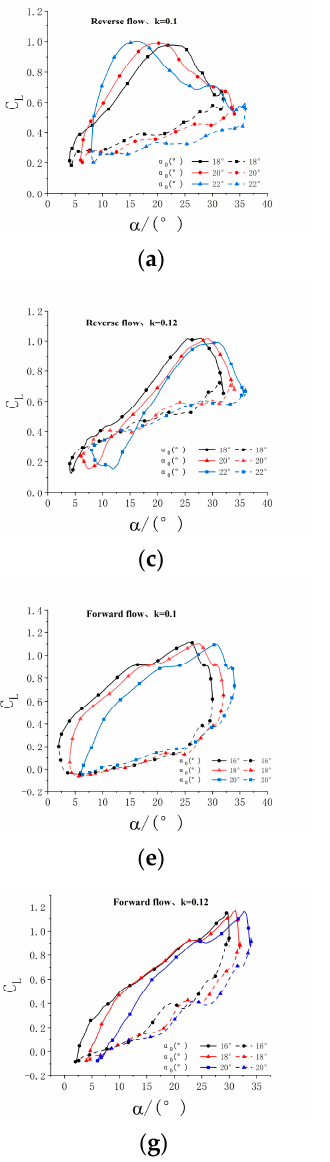
12 of 22 Figure 13. Pressure coefficient of suction and pressure sides of airfoil under reverse-blowing. 3.2. Effect of the Mean Angle 3.2.1. Effect of the Mean Angle of Pitch at Different K The NACA 0018 airfoil model oscillates periodically around the quarter chord posi- tion according to Equation (1). The influence of the mean angle of pitch, oscillation ampli-